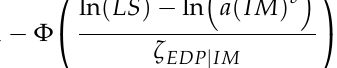
12 of 17 Table 13. Regression coefficients, standard deviation, and function for EDP – IM data pairs. Model